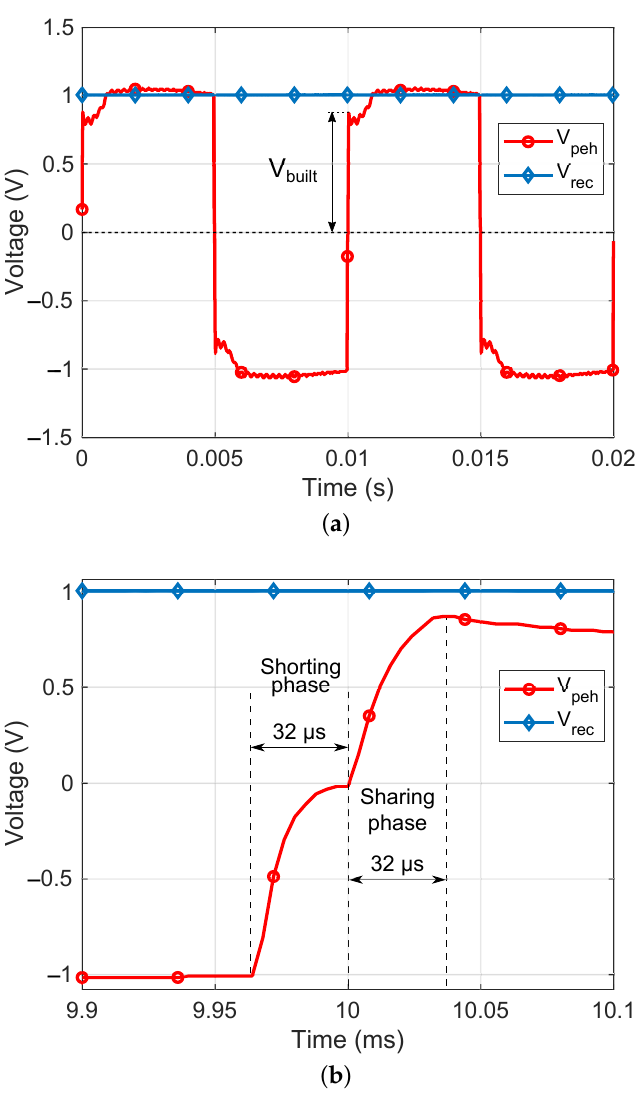
Figure 13. ( a ) Measured waveform of V peh and V rec , and ( b ) Zoom view during the voltage flip operation. VR regulated V rec to ˆ V OC = 1 V